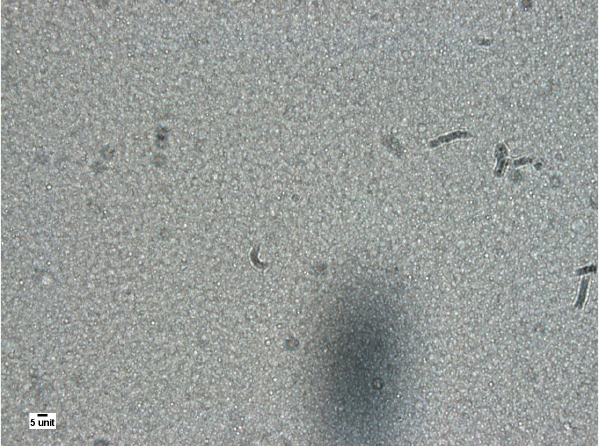
Figure 2. Pictures of the SMK AiO nutritional solution (1000× magnification with oil immersion), scale bar: 5 µm.